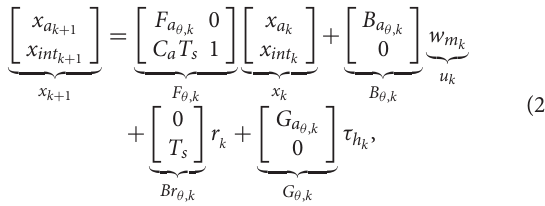
FIGURE 2 | Experimental identification. Frequency response measurements of theoretical (dashed) and experimental (solid) transfer functions between input ω d m and output F s . Graphs show responses for passive (blue), resistive (red) and fixed (black) modes.